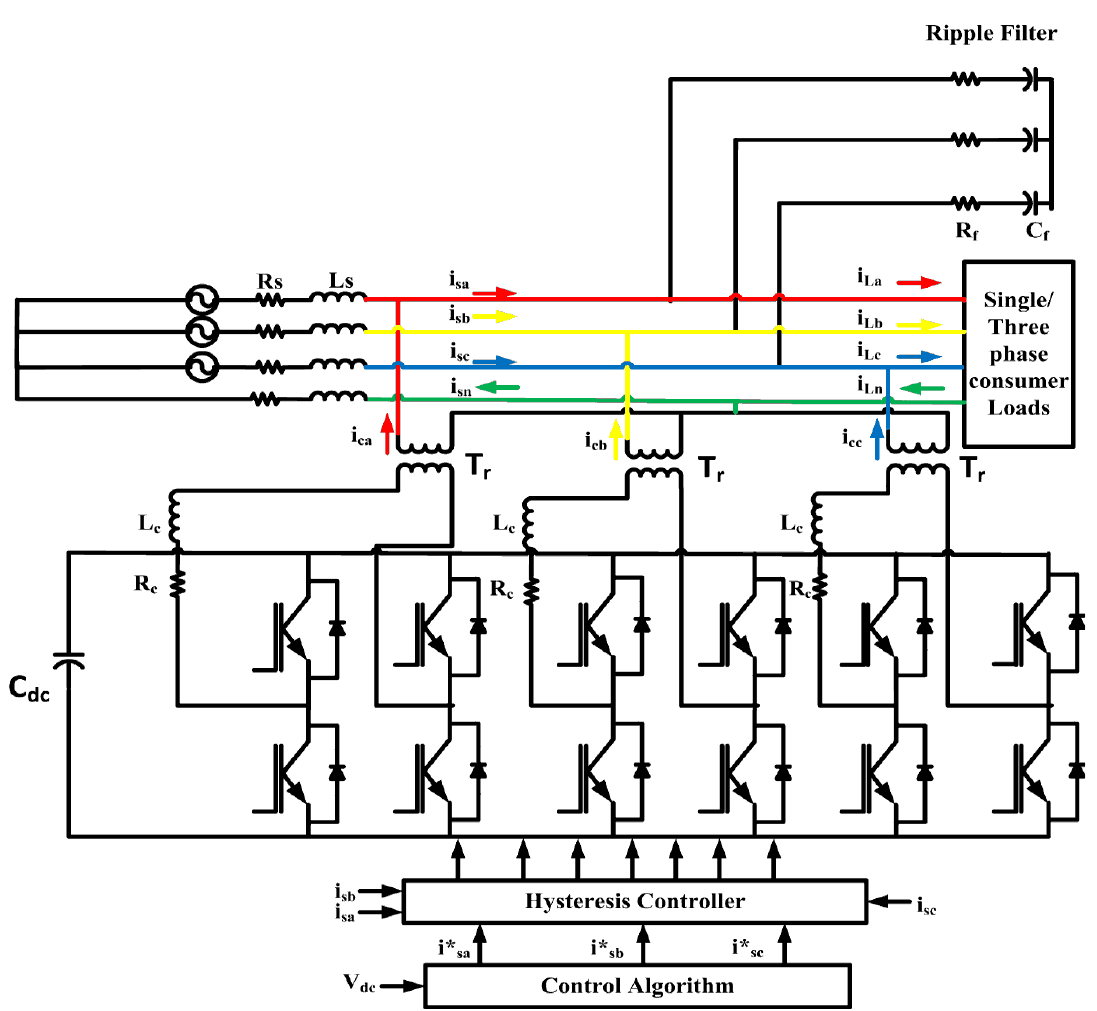
Figure 1. Configuration of H-bridge-based DSTATCOM system (* indicates reference value).